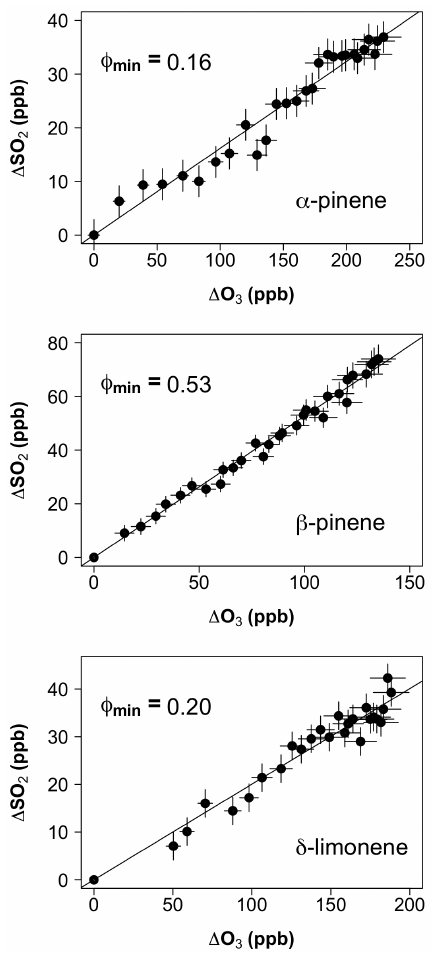
Figure 1. (cid:49) SO 2 vs. (cid:49) O 3 during excess-SO 2 experiments ([H 2 O]<5 × 10 15 cm − 3 ) . The gradient determines the minimum SCI yield ( ϕ min )